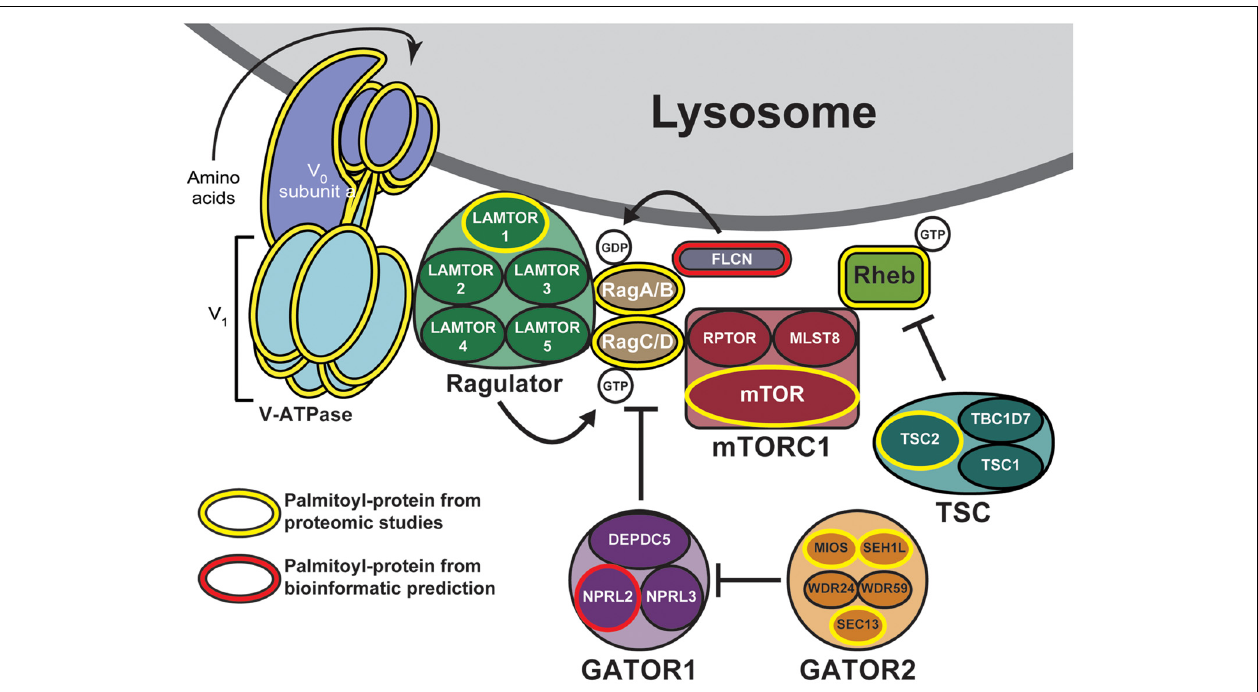
FIGURE 1 | Putative palmitoylated proteins of the mechanistic target of rapamycin (mTOR) signaling pathway. Palmitoyl-proteomic studies have identified a number of mTOR signaling components as potentially palmitoylated (outlined in yellow) including mTOR itself, subunits of the vacuolar ATPase, components of the regulatory GATOR2, Ragulator, and tuberous sclerosis complex (TSC) complexes, and other regulatory proteins. Additional mTOR signaling components are bioinformatically predicted to be palmitoylated (outlined in red).